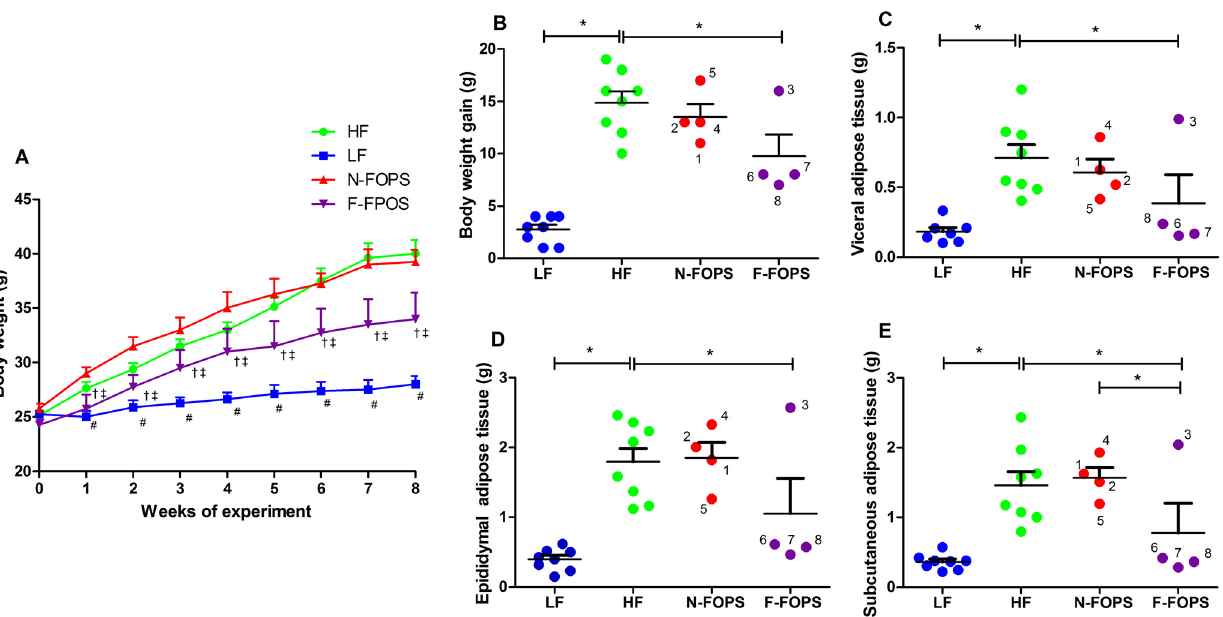
Fig 3. Body and adipose tissue weights in mice after 8 weeks of feeding. Body weight (A), body weight gain (B), and visceral (C), epididymal (D), and subcutaneous (E) adipose tissue weights; data are presented as mean ± SEM; n = 8 mice/group for HF and LF; n = 4 mice/group for N-FOPS and F-FOPS; mouse numbers are shown for FOPS mice to track individual mice across figures; * indicates a significant difference between the indicated treatments using Bonferroni ’ s multiple comparison test with the following comparisons: LF vs. HF; HF vs. N-FOPS; HF vs. F-FOPS; N-FOPS vs. F-FOPS; #, p < 0.05 vs. HF; † , p < 0.05 vs. HF; ‡ , p < 0.05 vs. N-FOPS.